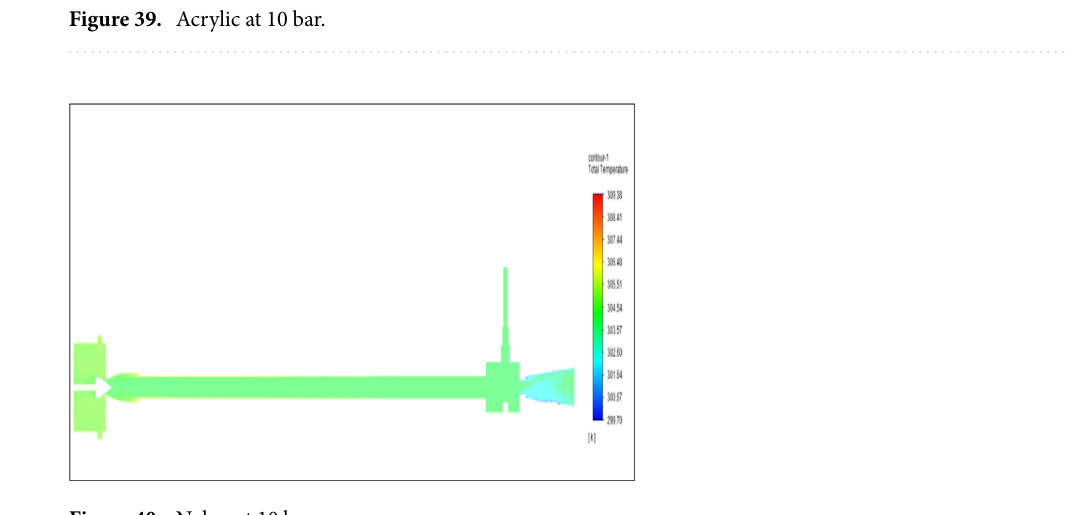
Figure 40. Nylon at 10